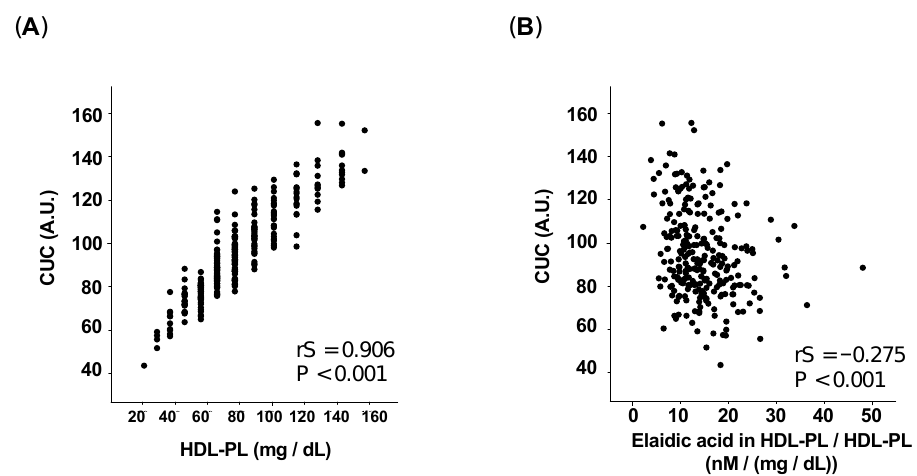
Figure 1. Correlations between CUC and the following: ( A ) HDL-PL levels (rS = 0.906, p < 0.001), ( B ) elaidic acid in HDL PL/HDL-PL ratio (rS = − 0.275, p < 0.001). CUC, cholesterol uptake capacity; A.U., arbitrary units; HDL-PL, high-density lipoprotein phospholipid.